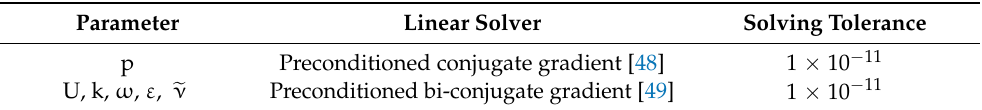
Table 2. A summary of linear